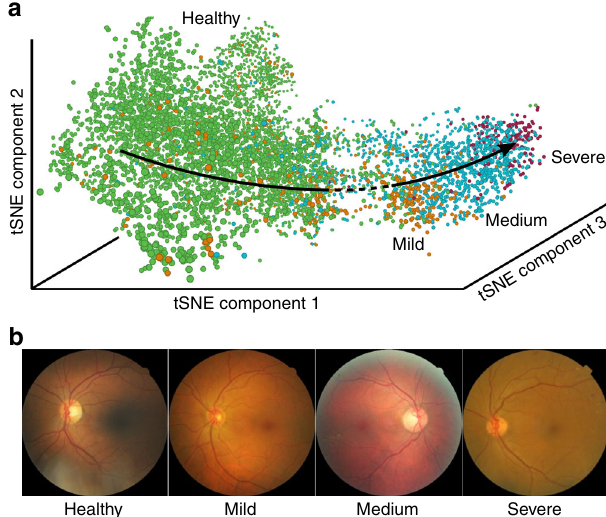
Fig. 6 Reconstruction of disease progression in diabetic retinopathy. a tSNE visualization of activation space representation, colored according to the disease states. b Randomly chosen images for each